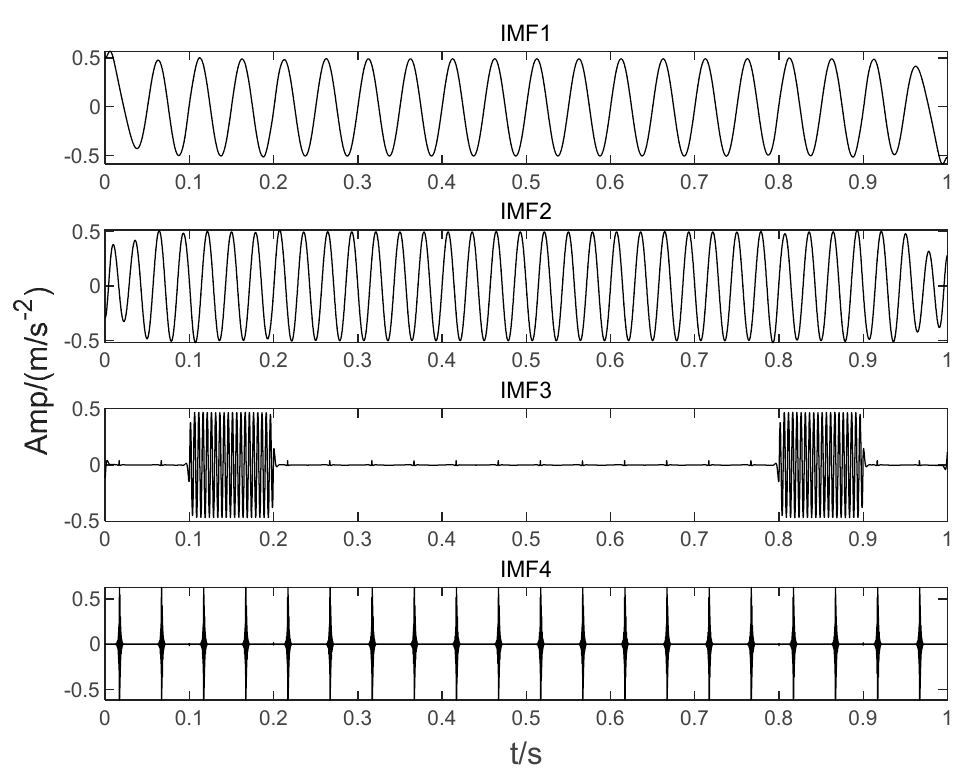
Figure 12. Decomposition of the mixed signal by proposed BT-EVMD method.